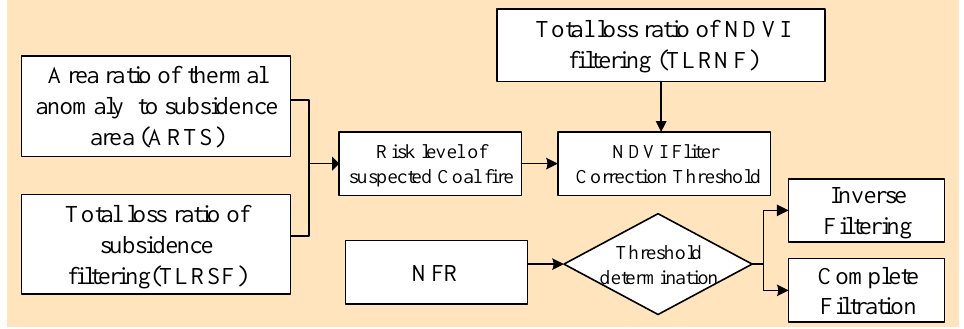
Figure 5. Flow chart of the NDVI filtering result (NFR) correction .